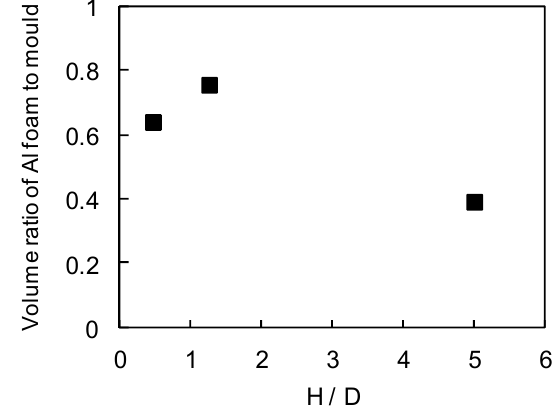
Figure 5. Relationship between volume ratio of Al foam to mold inside and aspect ratio of